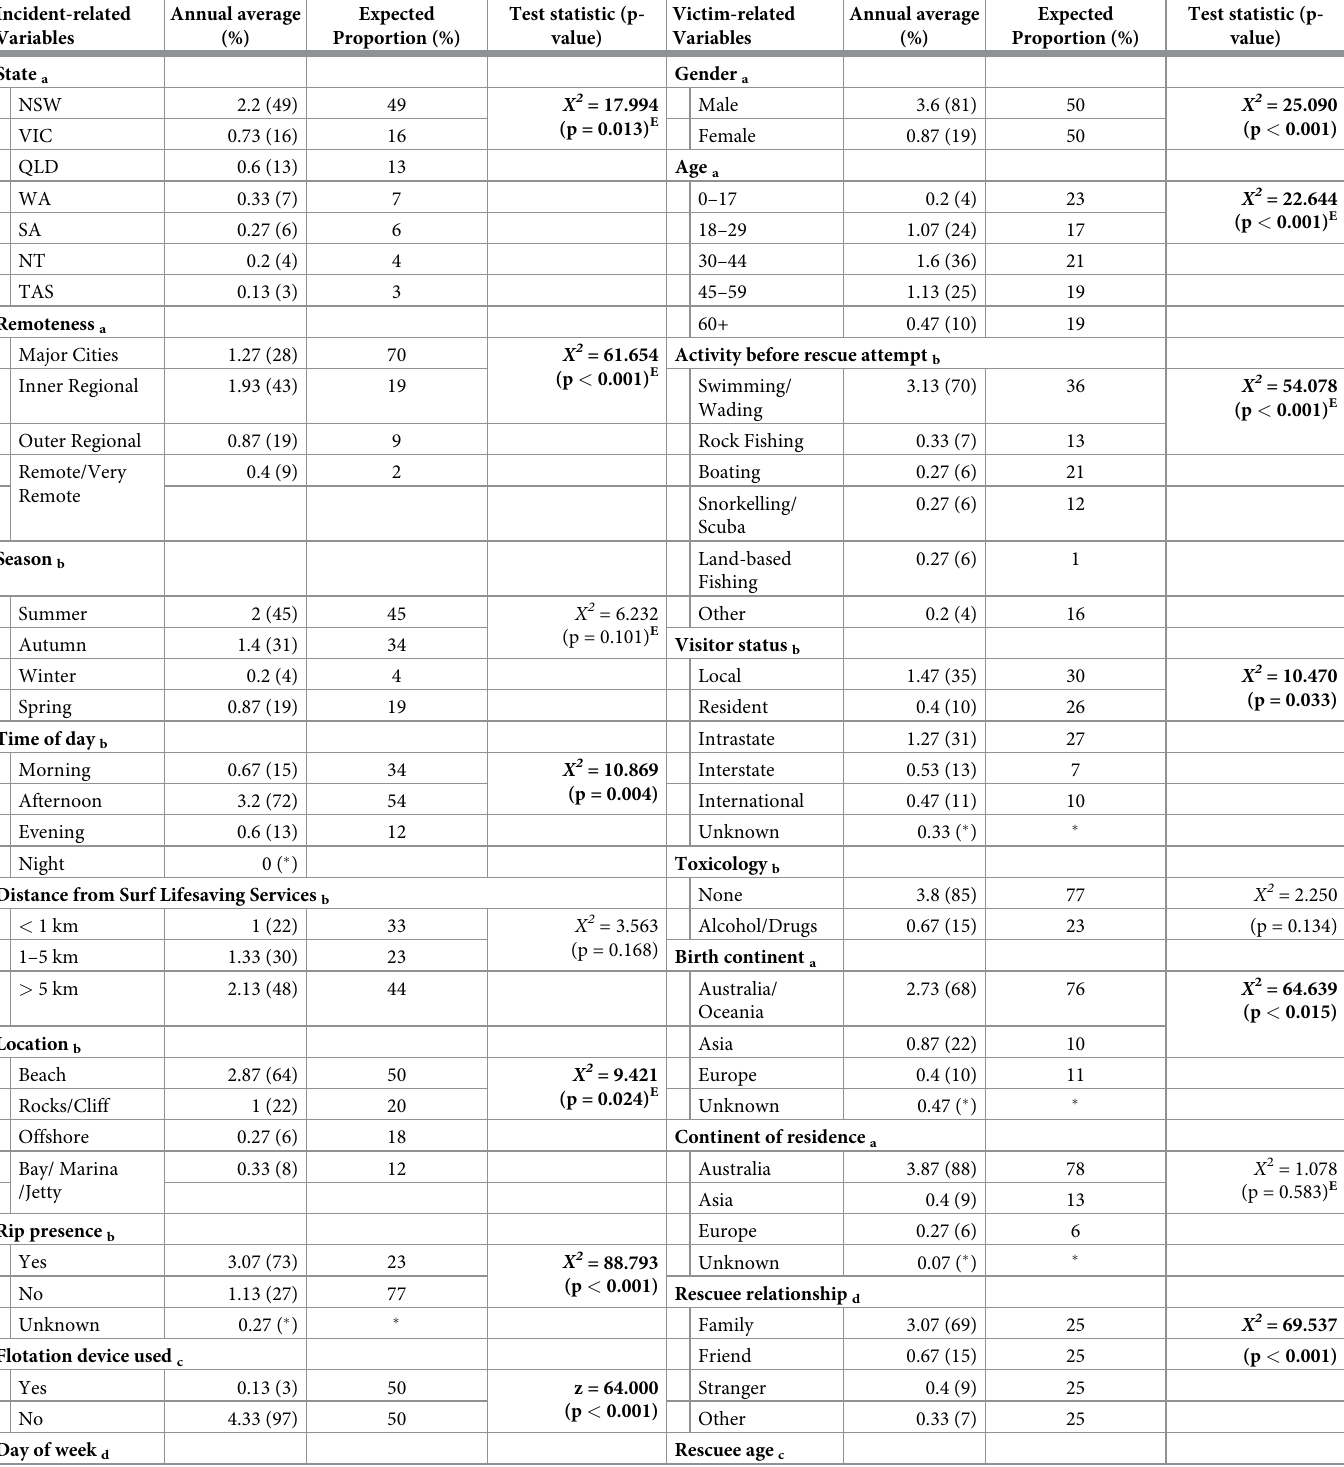
Table 2. Descriptive analyses of fatal coastal bystander rescue